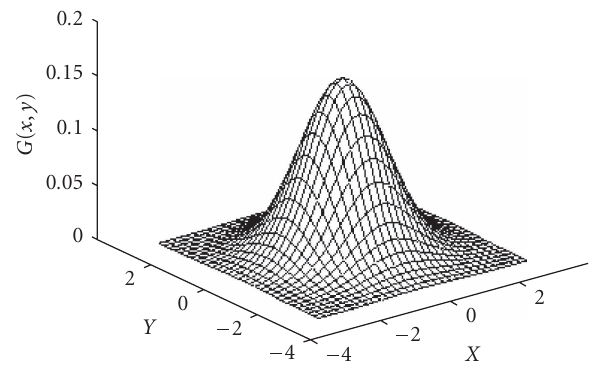
Figure 2.1. A Gaussian kernel, with x = 5, y = 5 and σ = 1 . 0. (Source: [2])